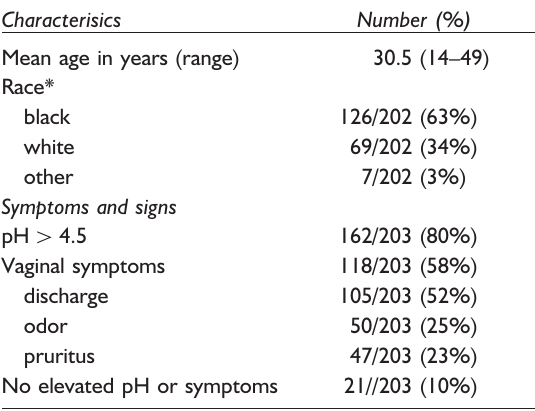
Table 1 Demographic characteristics and prevalence of symptoms and elevated pH in study population of